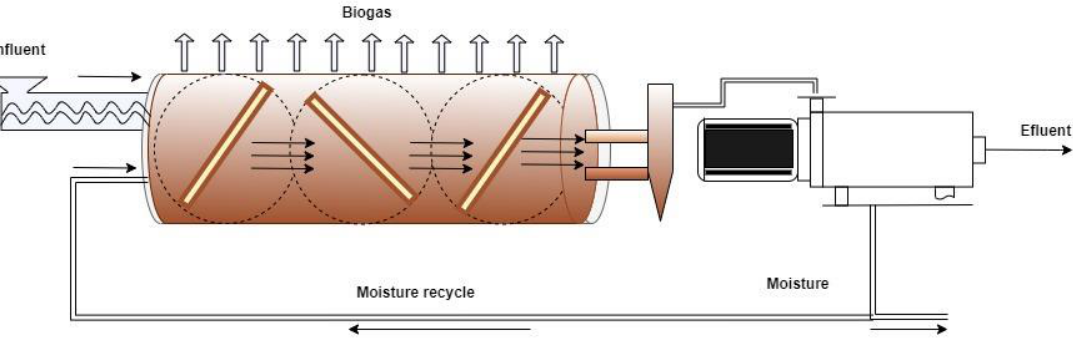
Figure 7. The reactor that provides the Strabag process.